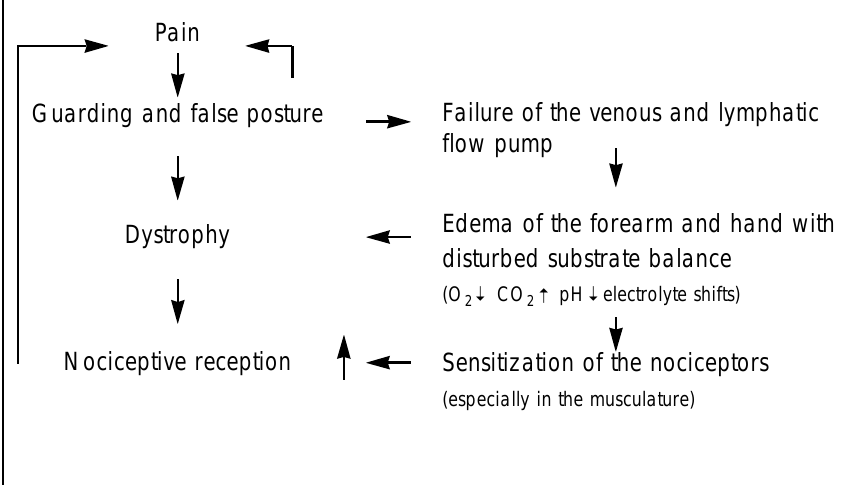
Figure 1: Pain and immobilization in the pathogenesis of reflex sympa- thetic dystrophy.